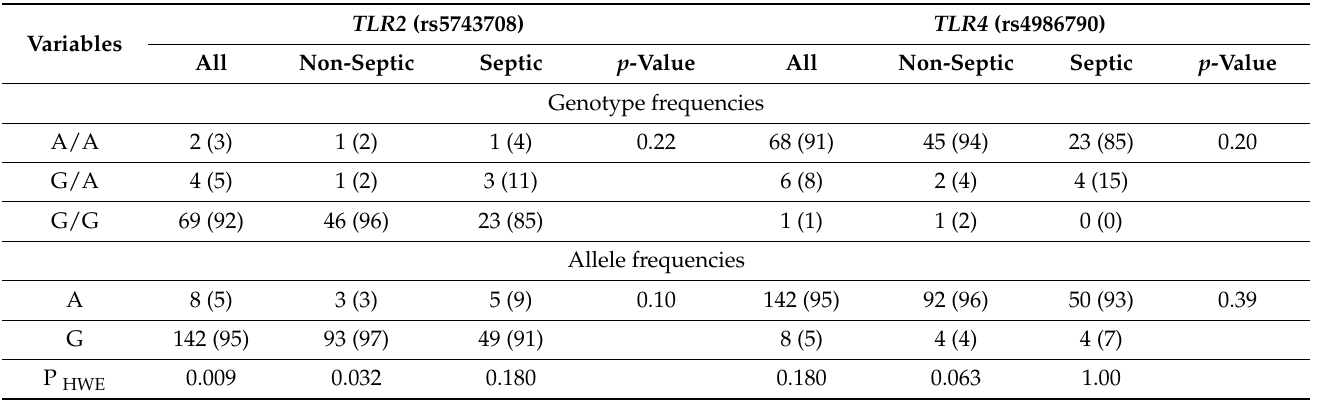
Table 3. Genotype and allele frequencies of TLR2 and TLR4 genes in the study population according to developing or not developing sepsis.